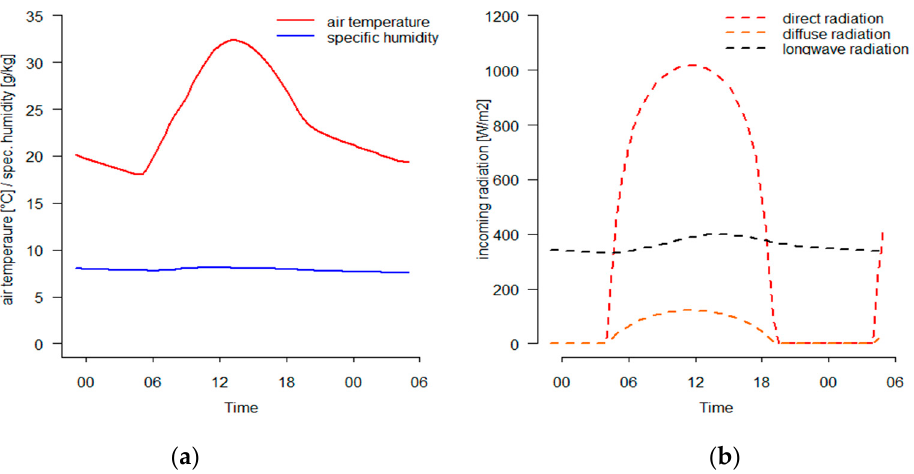
Figure 3. Diurnal profile of ( a ) air temperature, specific humidity, and ( b ) shortwave and longwave radiation.